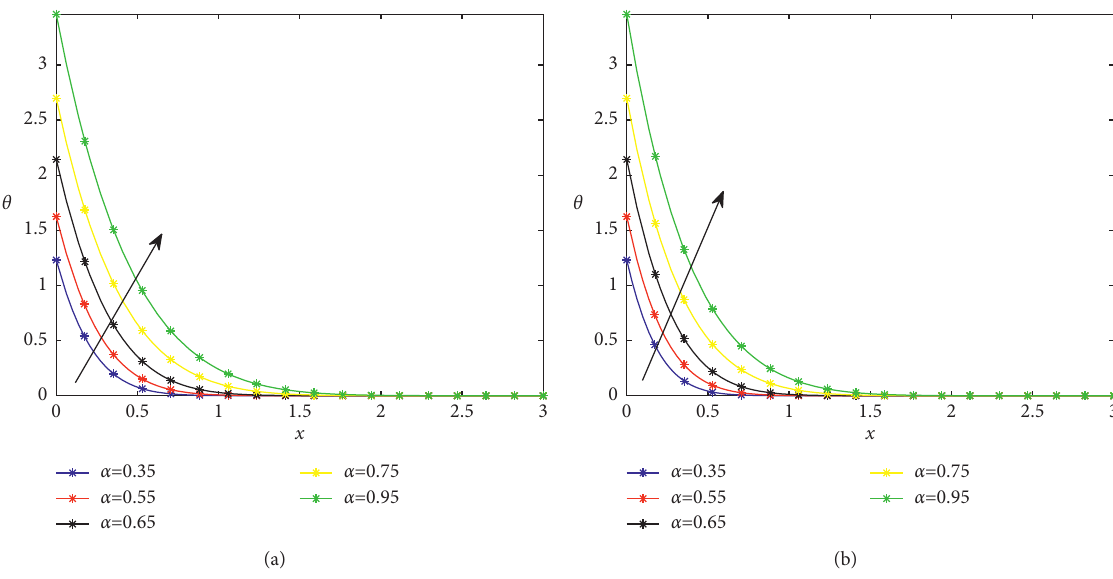
Figure 4: Concentration for different values of the order α for Sc � 20 (a) and Sc � 25